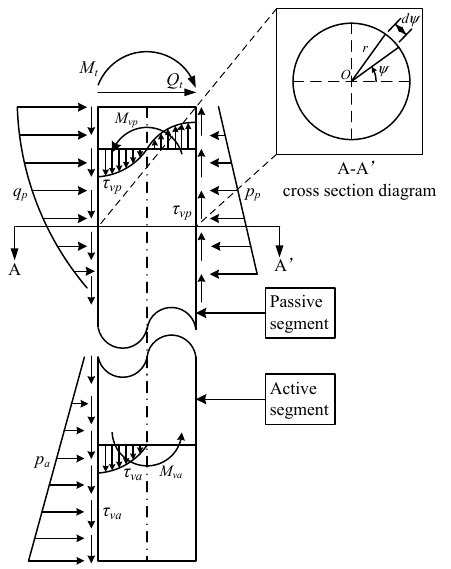
Figure 2. Distribution diagram of vertical friction caused by lateral deformation.